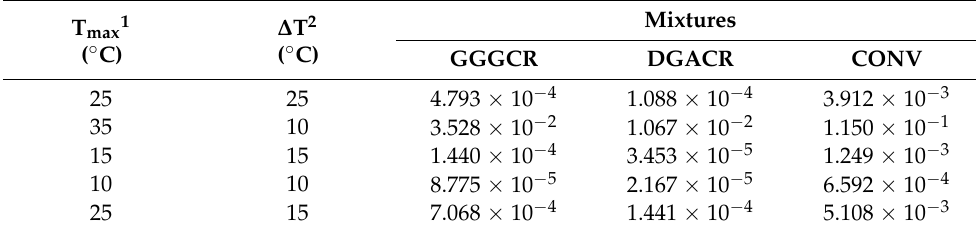
Table 8. Monthly damage.